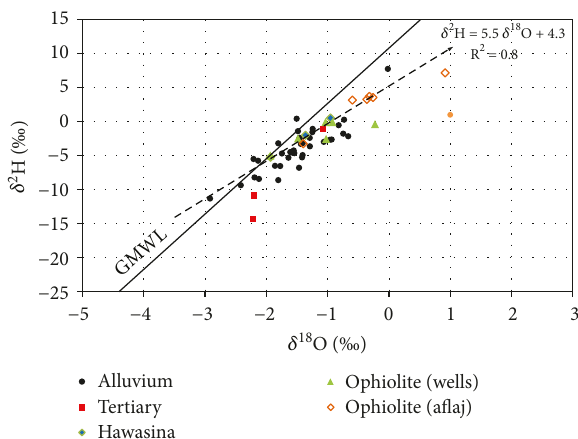
Figure 6: δ 2 H and δ 18 O are plotted with reference to the global meteoric water line